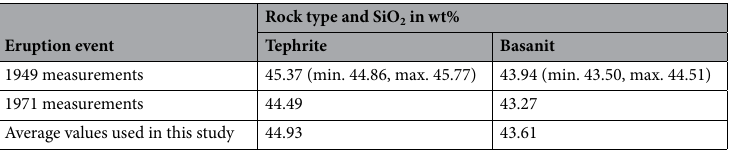
Table 2. Silica content of previous eruptions at Cumbre Vieja 45,46 and average values used in this study to investigate the 2021 eruption event.